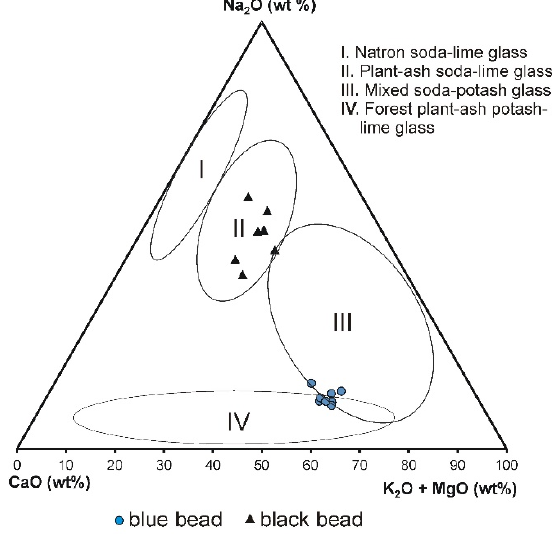
Figure 12. Ternary diagram of the normalized Na 2 O, K 2 O + MgO and CaO contents of the two glass beads analysed by EDS. Four main chemical glass types are evidenced by the ellipses [28].